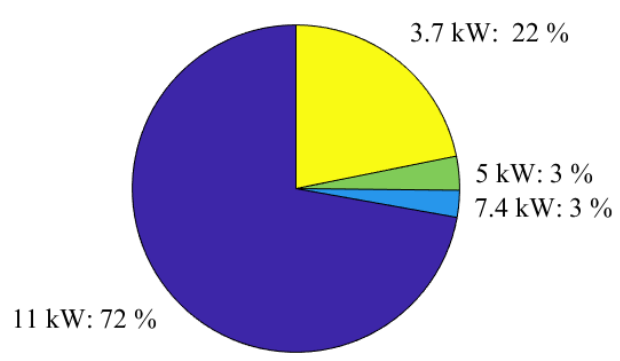
Figure 8. Rate of charge of the vehicles charging at Dansmästaren during 2021. About 72% of the vehicles charging at Dansmästaren during 2021 charged at 11